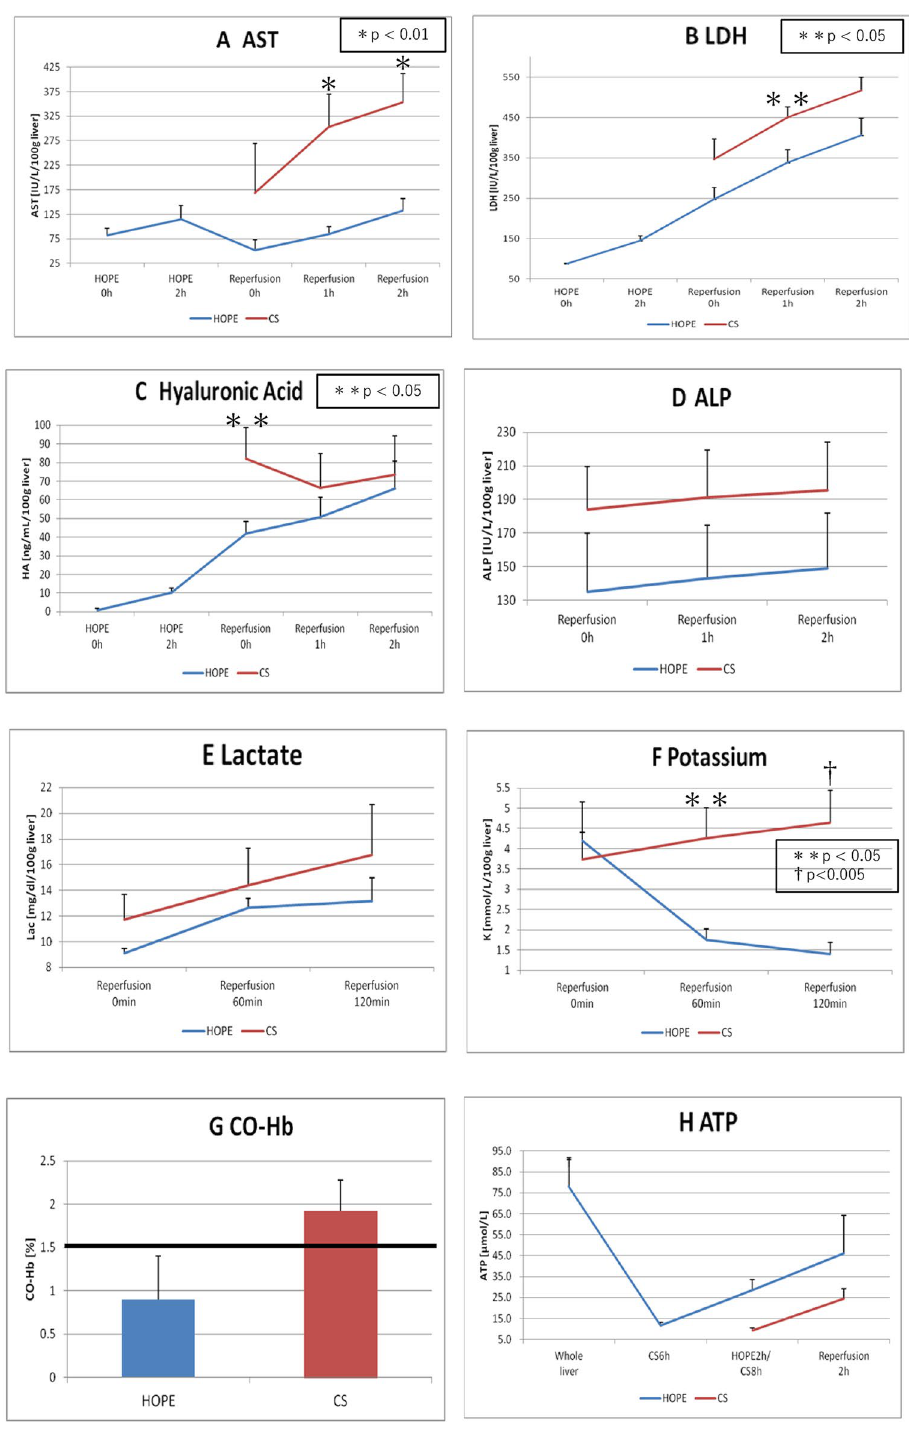
Figure 3. Laboratorial results. ( A ) Aspartate aminotransferase concentration (IU/L/100 g liver), ( B ) lactate dehydrogenase concentration (IU/L/100 g liver), ( C ) hyaluronic acid concentration (ng/mL/100 g liver), ( D ) alkaline phosphatase concentration (IU/L/100 g liver), ( E ) lactate concentration (mg/dL/100gliver), and ( F ) potassium concentration (mmol/L/100 g liver) value (mean ± SD) in the perfusate over time (hours) during HOPE and ERM. ( G ) Carboxyhemoglobin concentration (%) values (mean ± SD) in the perfusate at 2 h after ERM. (H) Tissue adenosine triphosphate level (μmol/L) values (mean ± SD) after laparotomy, after preservation (simple cold storage [CS] and HOPE), and at 2 h after isolated ERM. ERM ex vivo reperfusion model, HOPE hypothermic oxygenated machine perfusion preservation, SD standard